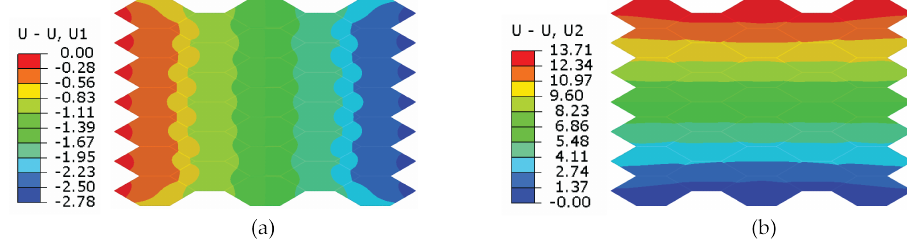
Figure 6. The actuation displacements (unit: mm) in ( a ) x and ( b ) y directions at 7.5